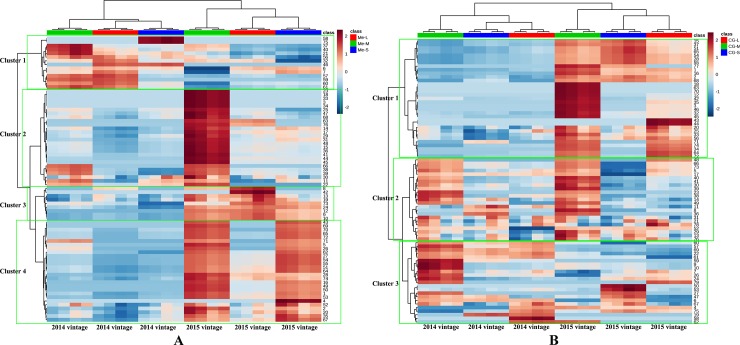
Hierarchical clustering analysis dendrogram for volatile compounds of Vitis vinifera L. cv. Merlot and Cabernet Gernischt in different size classes in 2014 and 2015.Me-L: Large berries of Merlot; Me-M: Middle berries of Merlot; Me-S: Small berries of Merlot. CG-L: Large berries of Cabernet Gernischt; CG-M: Middle berries of Cabernet Gernischt; CG-S: Small berries of Cabernet Gernischt. The number in each row in A and B corresponding to each volatile is presented in S2 Table and S3 Table, respectively.